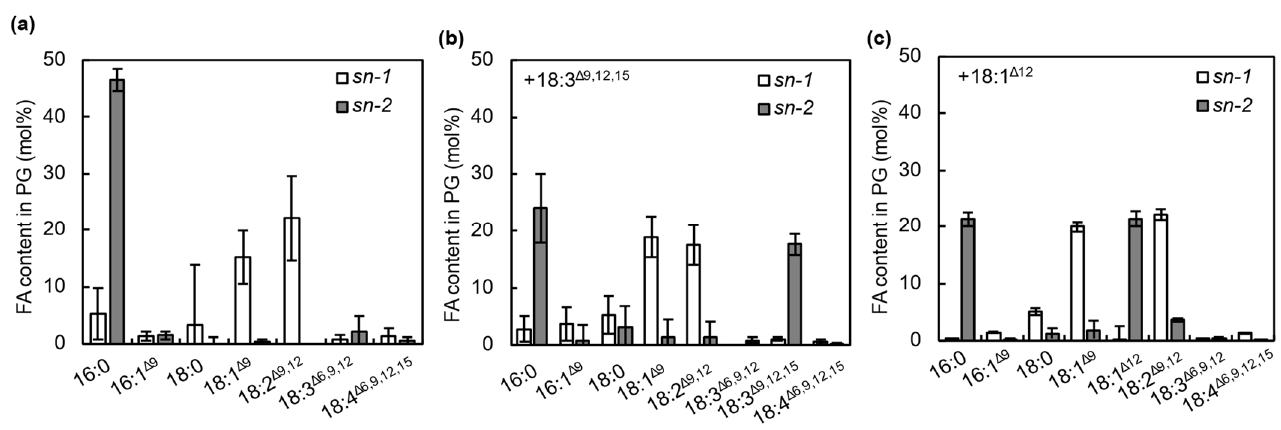
Figure 6. Distribution of incorporated unsaturated C18 FAs in PG molecules. PG molecules prepared from cells incubated without FA ( a ) and with 50 µ mol L − 1 18:3 ∆ 9,12,15 ( b ) or 18:1 ∆ 9 ( c ) under strong light at 1500 µ mol photons m − 2 s − 1 for 20 min were treated with honey bee phospholipase A 2 , and the resulting 1-acyl-lysoPGs were analyzed by thin-layer chromatography and gas chromatography to determine the composition of fatty acids at the sn -1 position of PG. The composition of fatty acids at the sn -2 position was calculated by subtracting the fatty acid composition at the sn -1 position from the total fatty acid composition. Values are the means ± SD (bars) of three independent experiments.